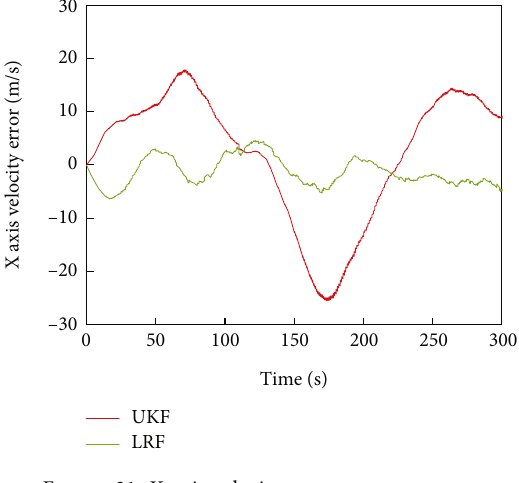
Figure 18: X -axis position error contrast curves